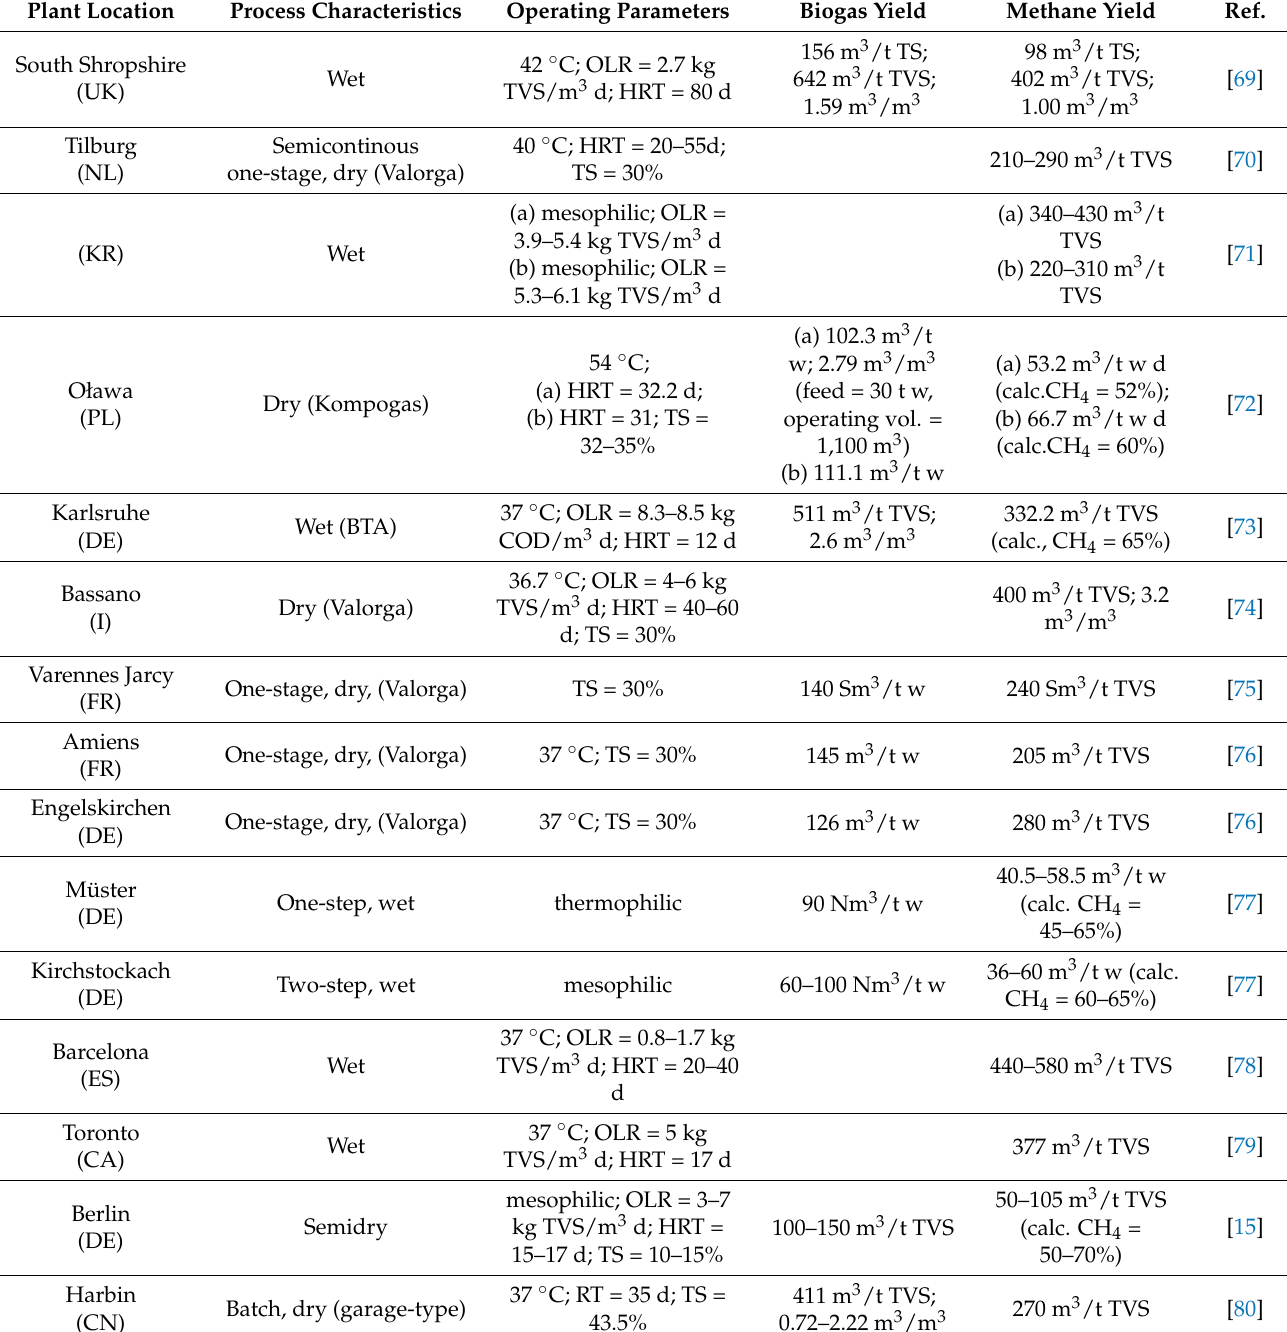
Table 3. Reported literature data of industrial biogas plants treating